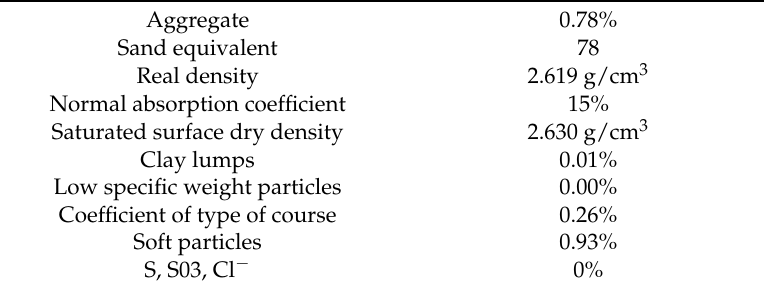
Table 2. Characterization of the sand used in the specimens.